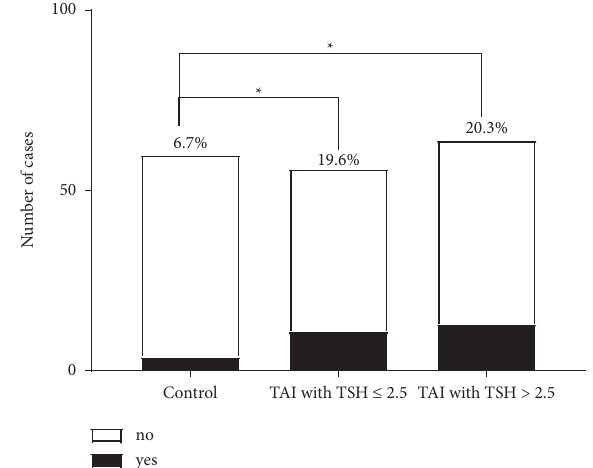
Figure 2: The comparison of fertilization rate between patients with TAI positive and controls.